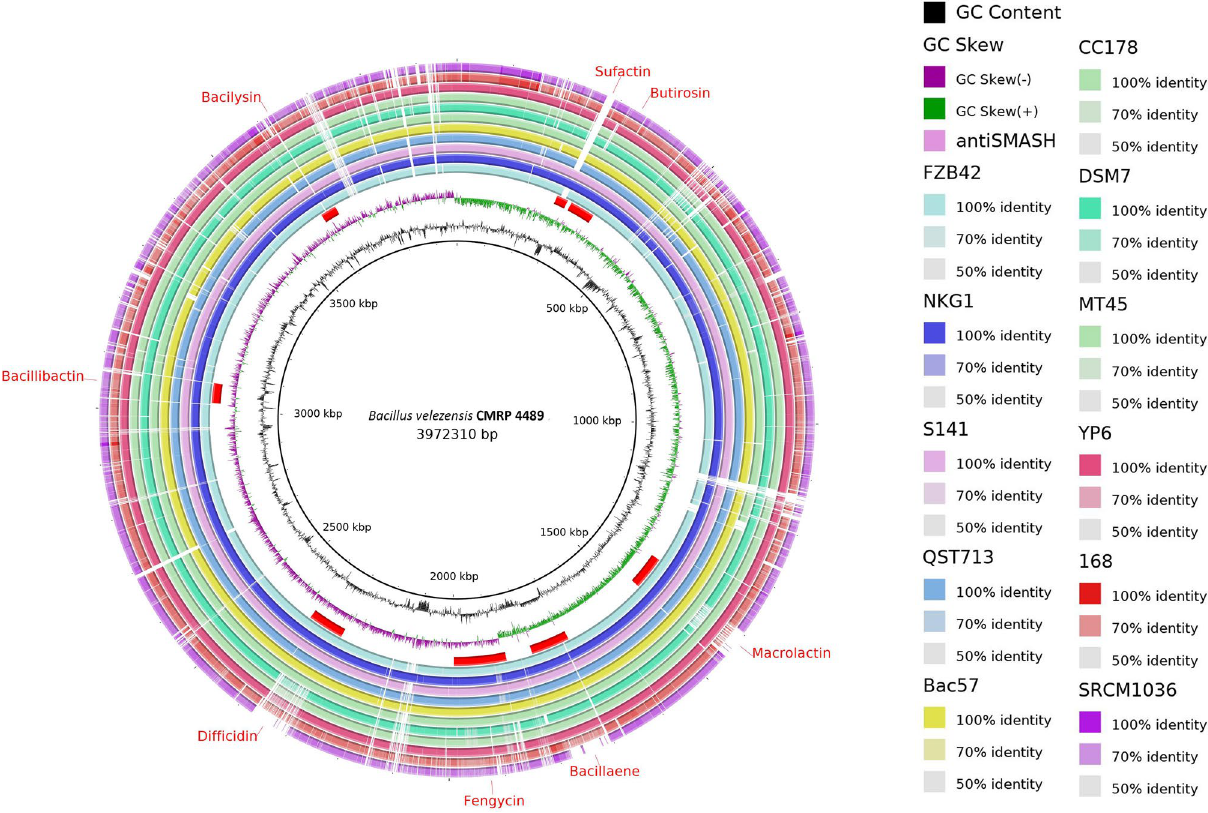
Figure 7. Circular representation and comparison of the Bacillus velezensis CMRP 4489 strain genome with other strains from the Bacillus subtilis group using the BRIG program. From the inside out: representation of the genome size of B. velezensis CMRP 4489, GC Skew, GC Content, positions of the clusters of the B. velezensis CMRP4489 strain, and the strains FZB42, NGK1, S141, QST713, Bac57, CC178, DSM7, MT45, YP6, 168, and SRCM1036,